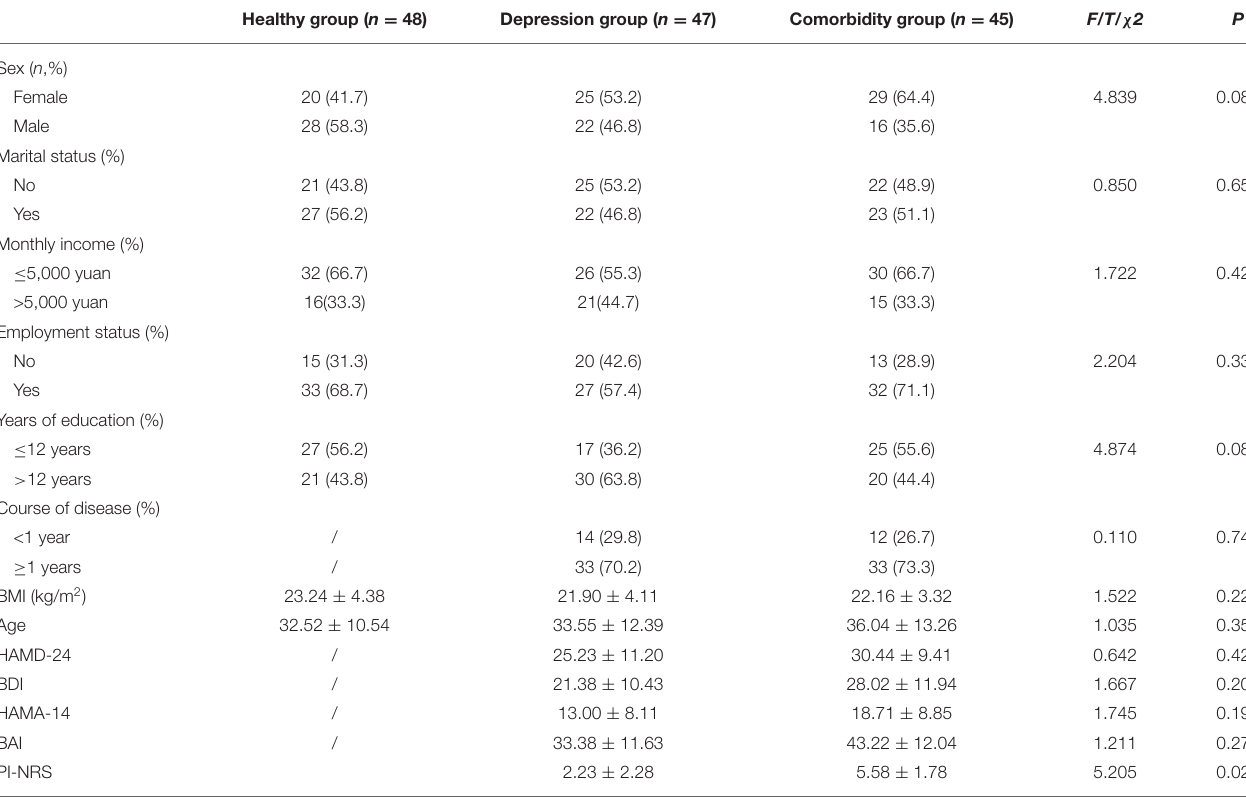
TABLE 1 | Comparison of sociodemographic characteristics, anxiety, depression symptom, and pain intensity among the three groups.